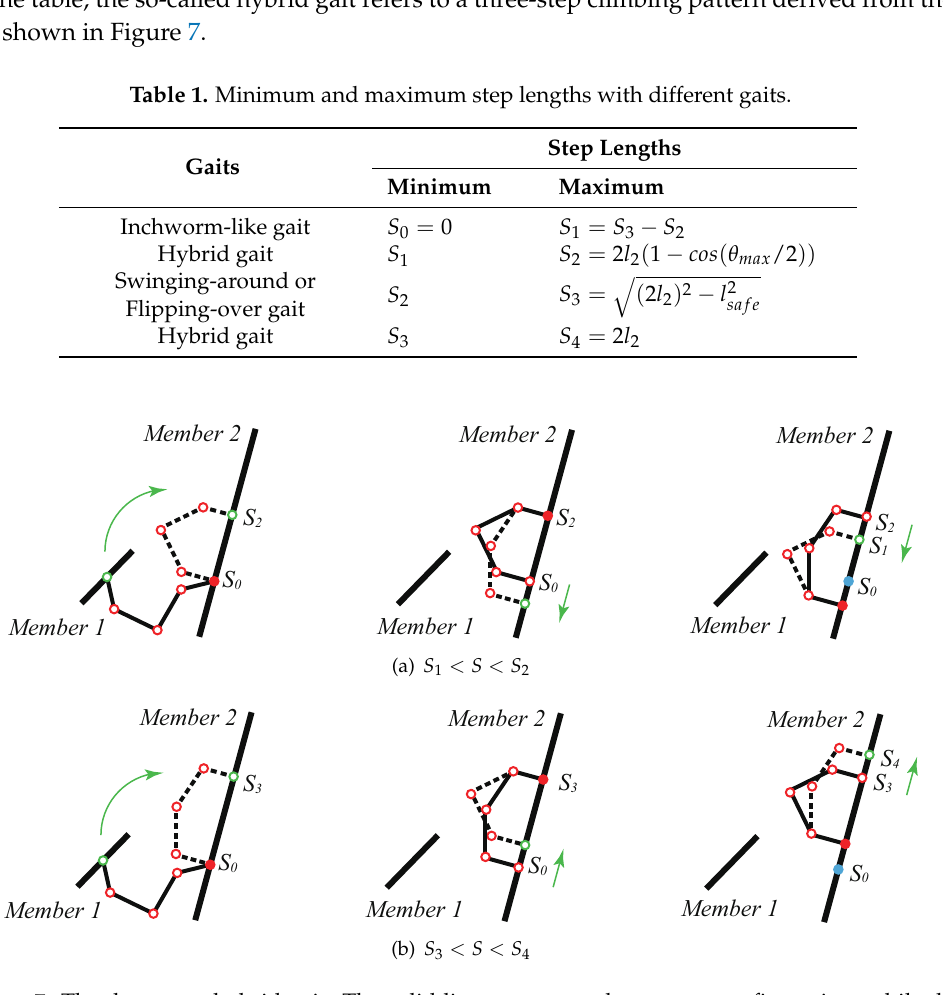
Figure 7. The three-step hybrid gait. The solid lines represent the current configuration, while the dashed ones stand for the following configuration one step